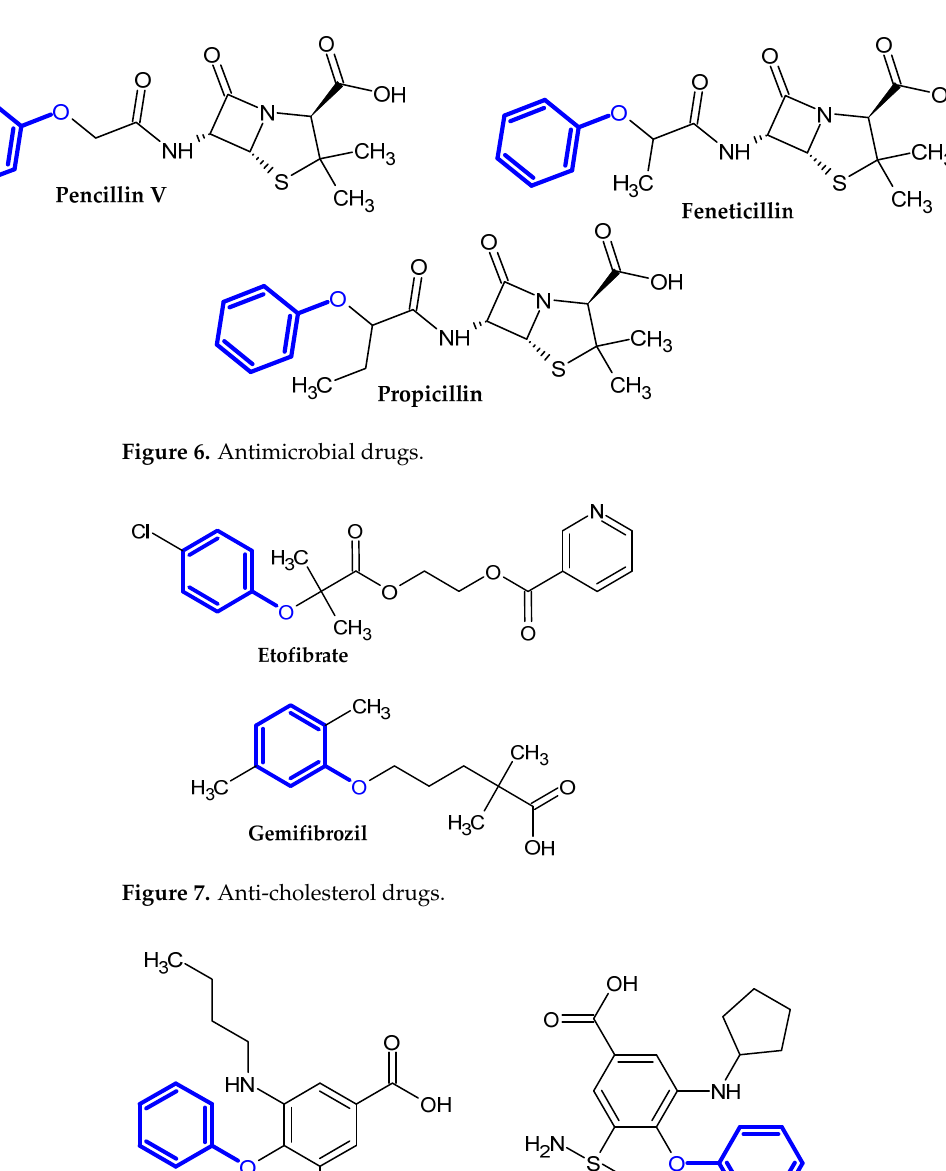
Figure 8. Diuretic drugs.